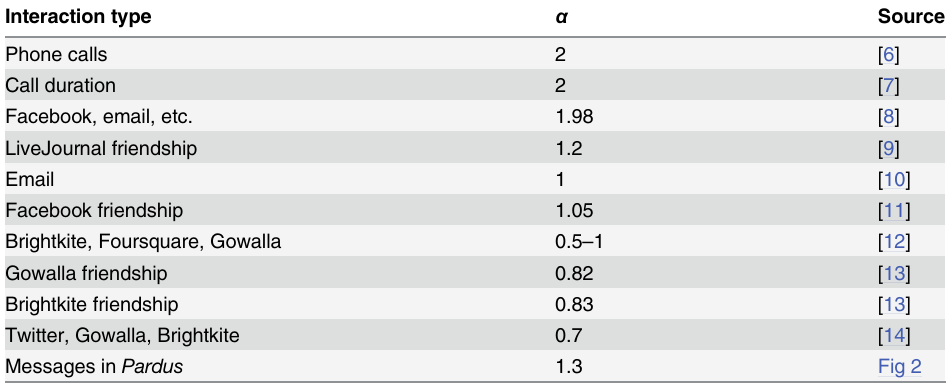
Table 1. Power-law exponents obtained from interaction probabilities as a function of distance for var- ious data sets. Interaction type α Source Phone calls